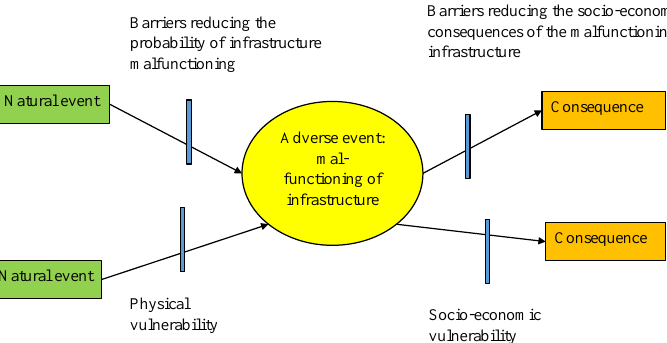
Figure 1. Schematic representation of the scope. Factors that affect the probability of the adverse event (malfunctioning of infrastructure) are shown on the left side (i.e. causes, barriers and physical vulnerability of the infrastructure). Factors that affect the socio-economic consequences of the adverse event are shown on the right